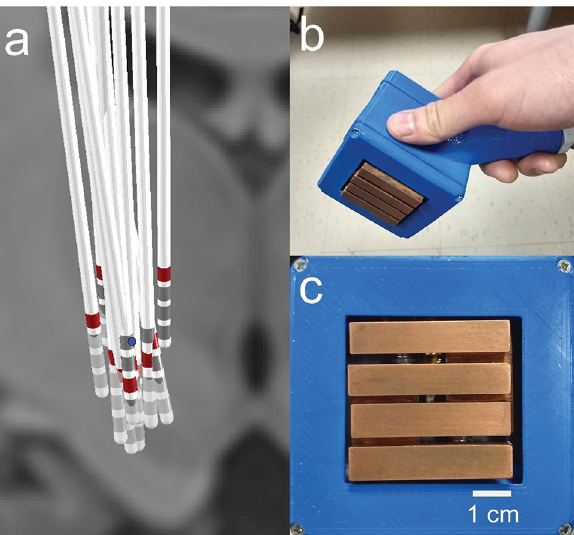
Figure 5. Deep brain stimulation sites and thermal stimulation device. ( a ) Estimated lead locations normalized to MNI space juxtaposed against the MNI152 NLIN 2009b T1 atlas. Active contacts used in the study are indicated in red. The average active contact location is indicated with the blue circle. ( b ) Device used to produce thermal stimuli. ( c ) Detail of device contact